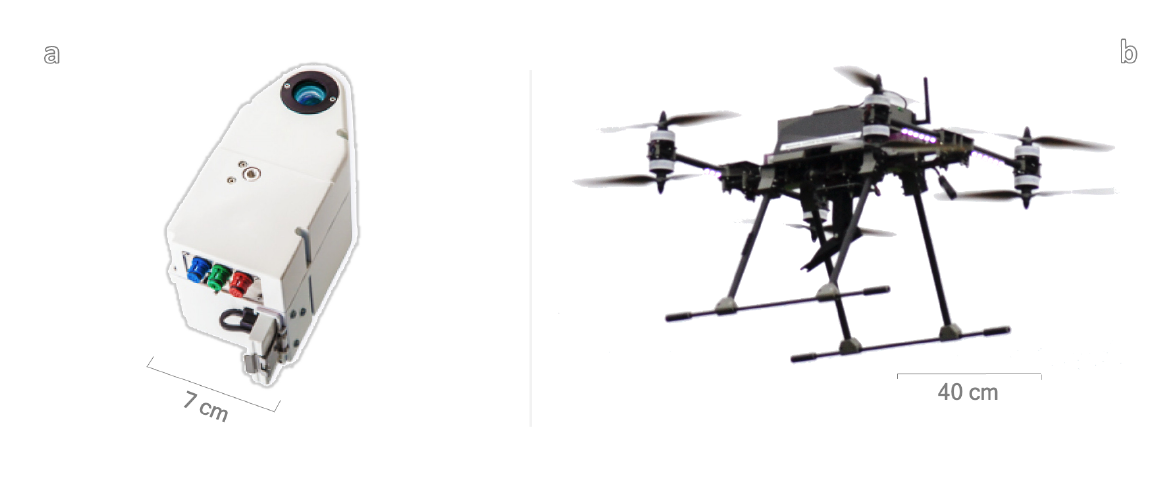
Figure 3. Overview of the unmanned aerial system (UAS) used for image acquisition: ( a ) The Rikola hyperspectral (HS) camera [24] mounted on the ( b ) Tholeg